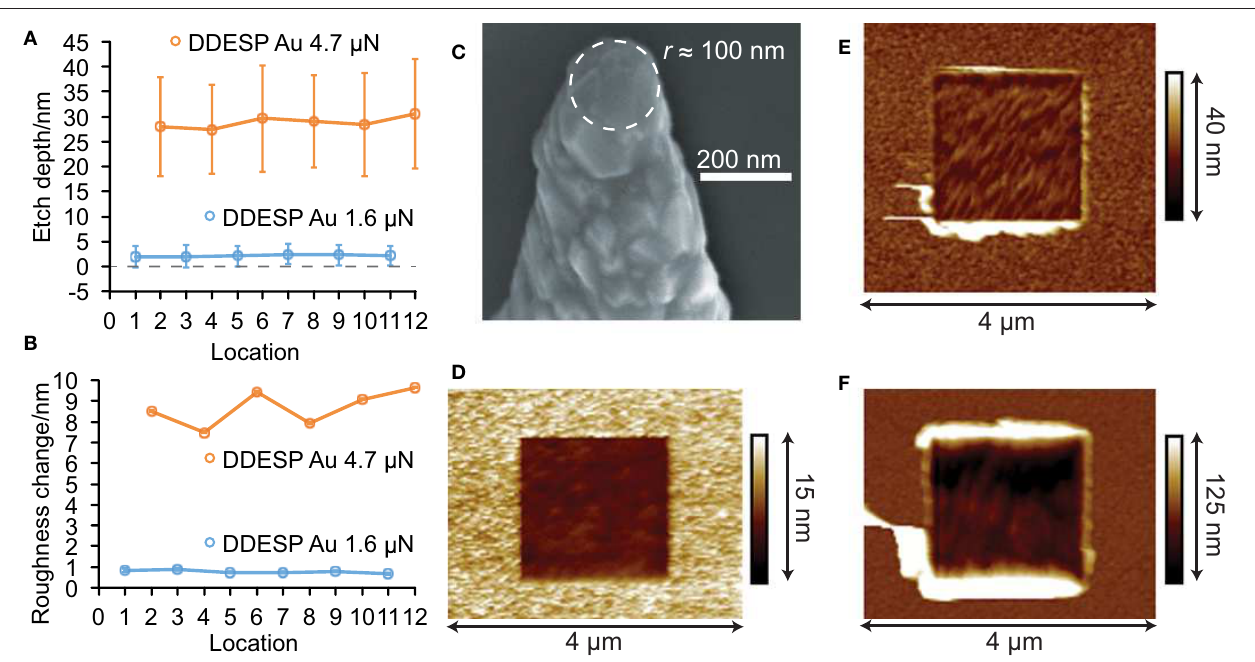
FIGURE 4 | Consistency of etching gold and comparison with SiO x . (A,B) Etch depth and roughness change, respectively, when etching the gold sample. The etch depth fluctuates although no general trend is present. Notably, the roughness of the etched regions increases by around a third of the etch depth. (C) SEM image of the probe following the etching processes in (A,B) . The probe does not appear worn as r is relatively small and grainy features are still visible at the apex. (D) AFM image of typical trench produced by the diamond-coated and full-diamond probes on SiO x . The trench is level and smooth compared to the surrounding material. (E,F) AFM images of the smoothest and roughest trenches produced on gold, at locations 11 and 12, respectively. Both of these are rougher than their surroundings and show severe wave-like